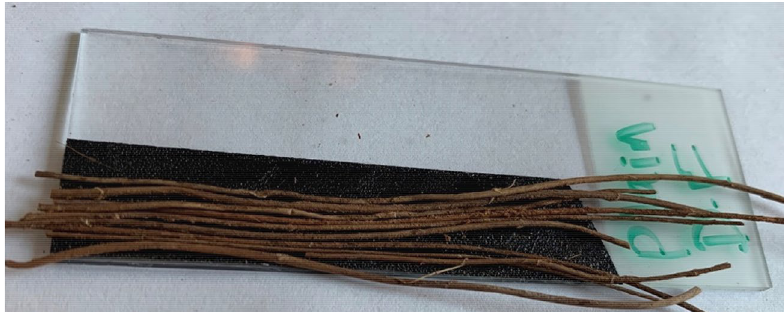
Figure 2. Fiber arrangement on a glass slide for contact angle measurement.